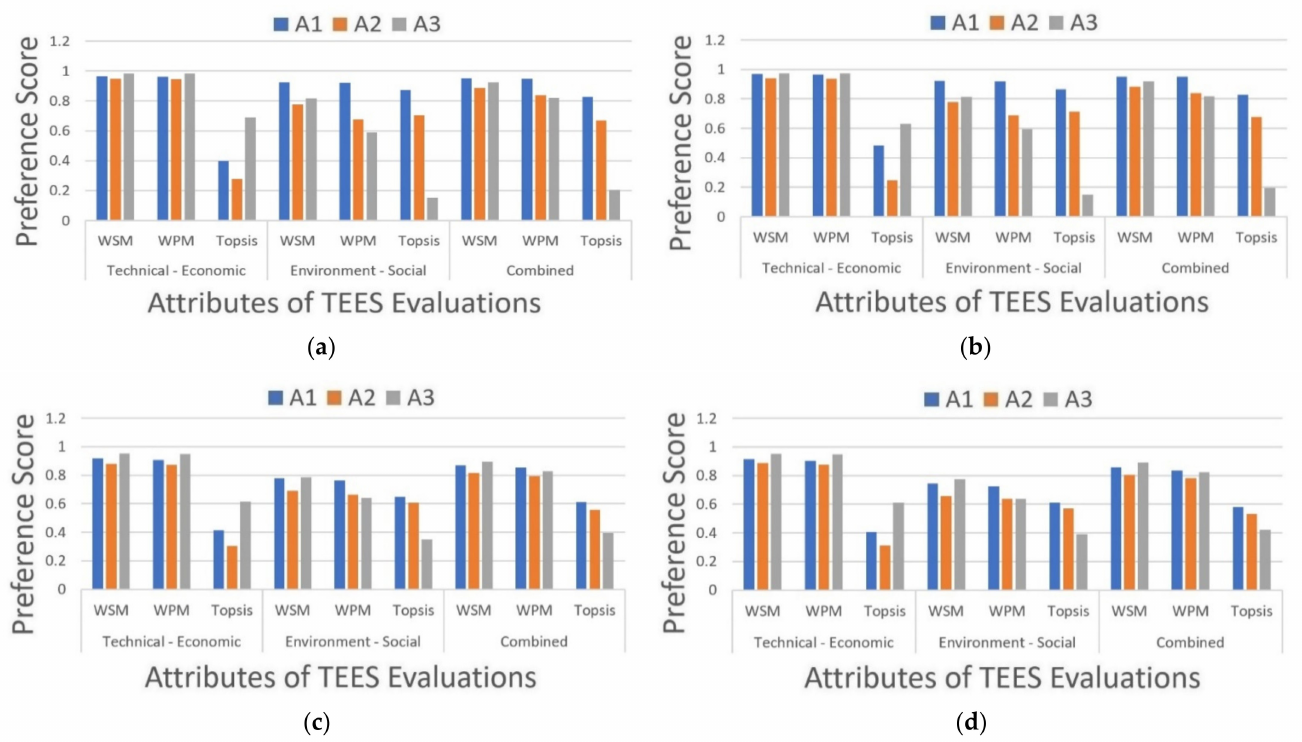
Figure 23. MCDM evaluations for Case 6 considering DG+DSTATCOM: ( a ) C6/S2 (LG1); ( b ) C6/S3 (OLG1); ( c ) C6/S4 (LG2); ( d ) C6/S5